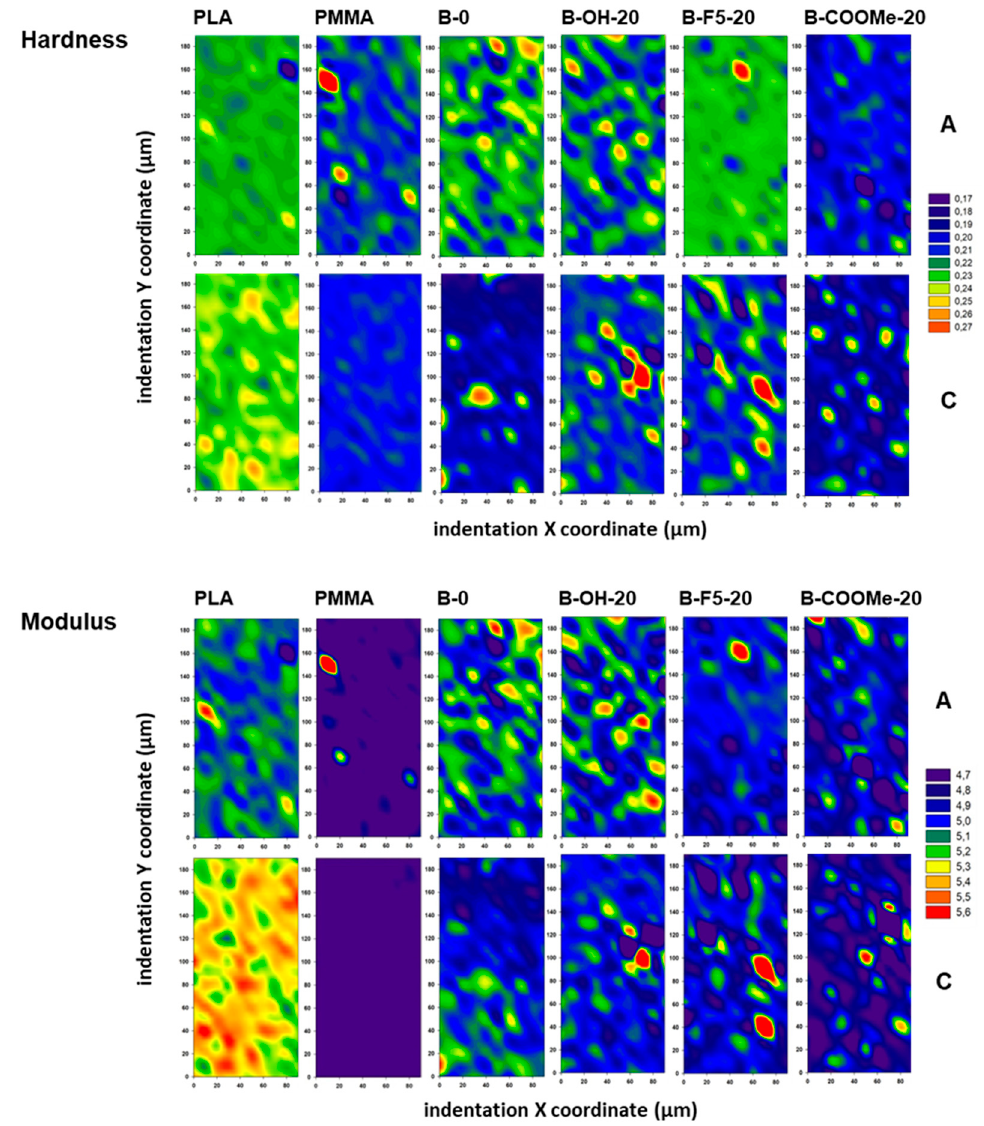
Figure 11. Maps of nanomechanical properties (hardness H and elastic modulus E ) in compression moulded samples of the neat components and selected blends (A: surface area; C: cross-section, middle area).